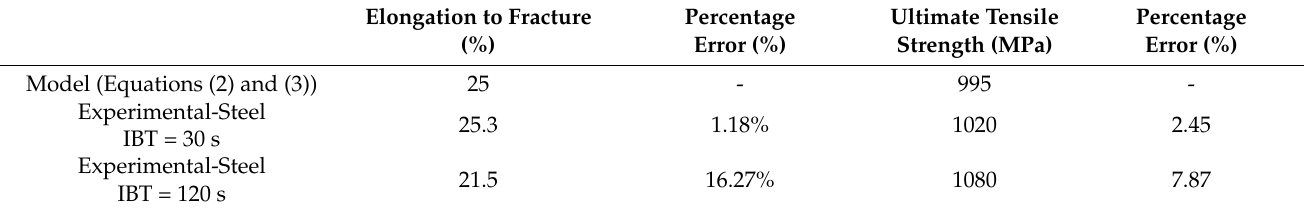
Table 2. Comparison between mechanical properties obtained by the model and those obtained experimentally. Elongation to Fracture Percentage Ultimate Tensile (%) Error (%) Strength (MPa) Error (%) Model (Equations (2) and (3))